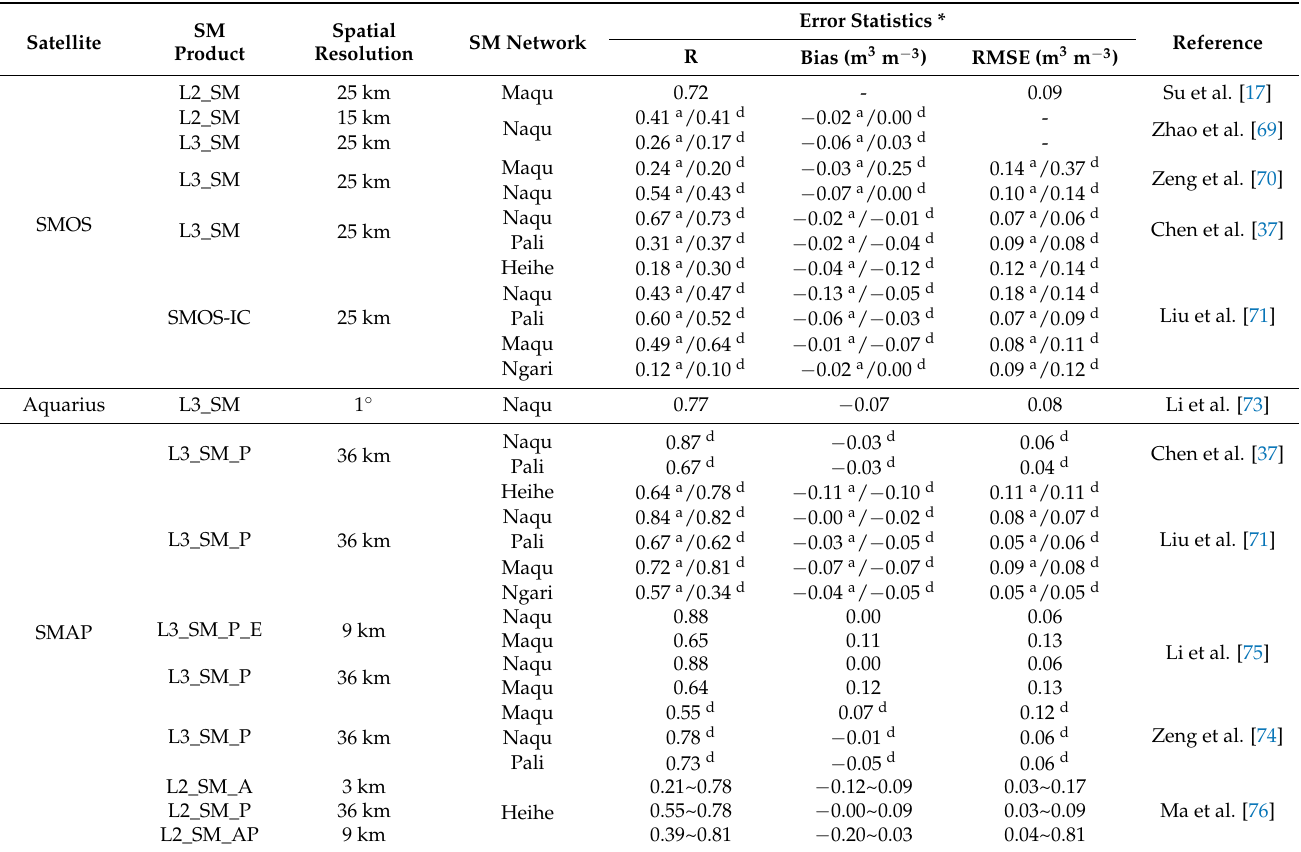
Table 4. Summary of error statistics for the validations of L-band satellite-based SM products performed on the